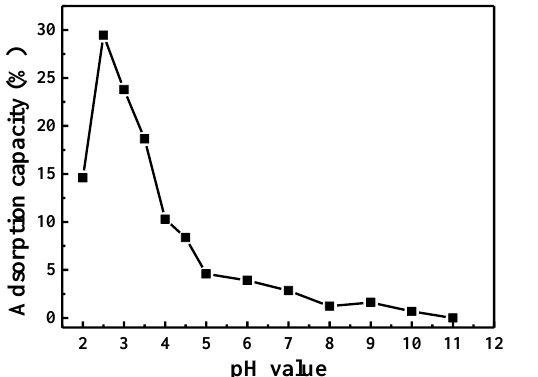
Figure 4. Effect of initial pH value on the adsorption of MO (MO: 10 mg/L, 50 mL; CuO: 20 mg).